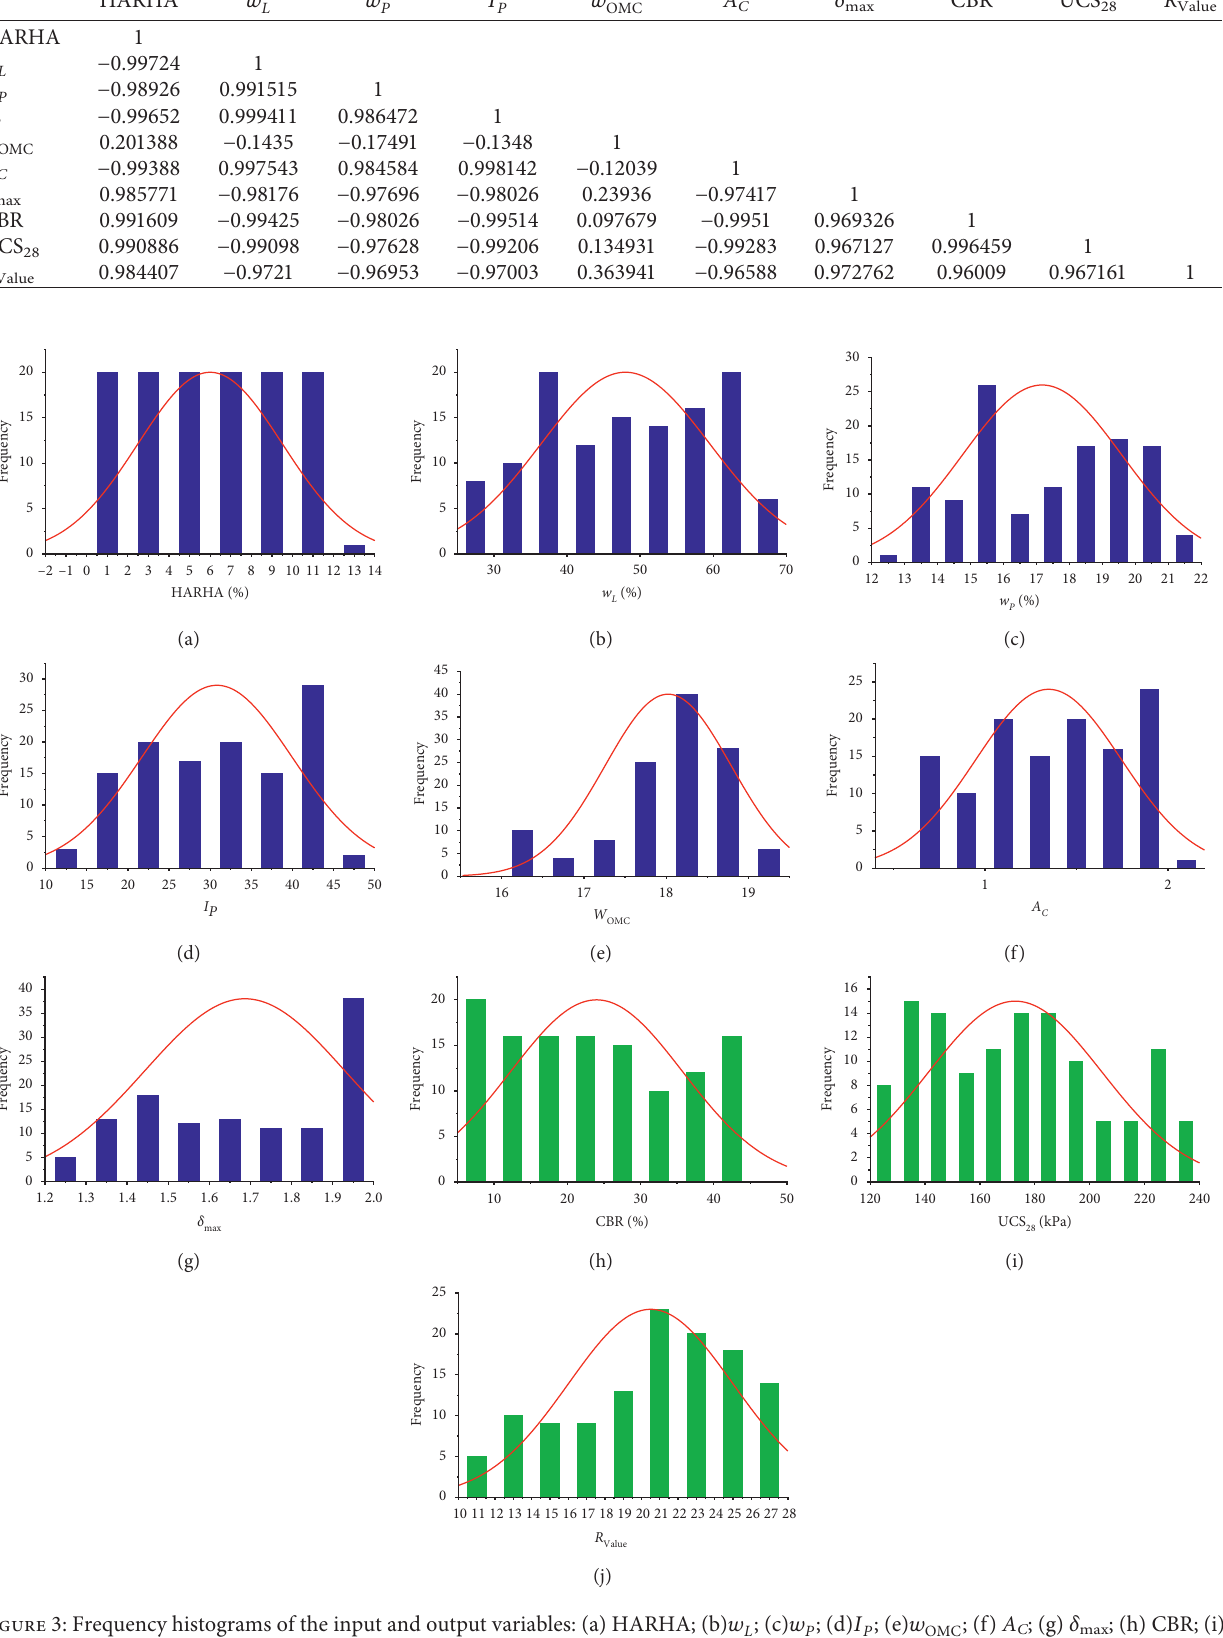
w I w ; (f) A C ; (g) δ max ; (h) CBR; (i) L ; (c) P ; (d) P ; (e) OMC